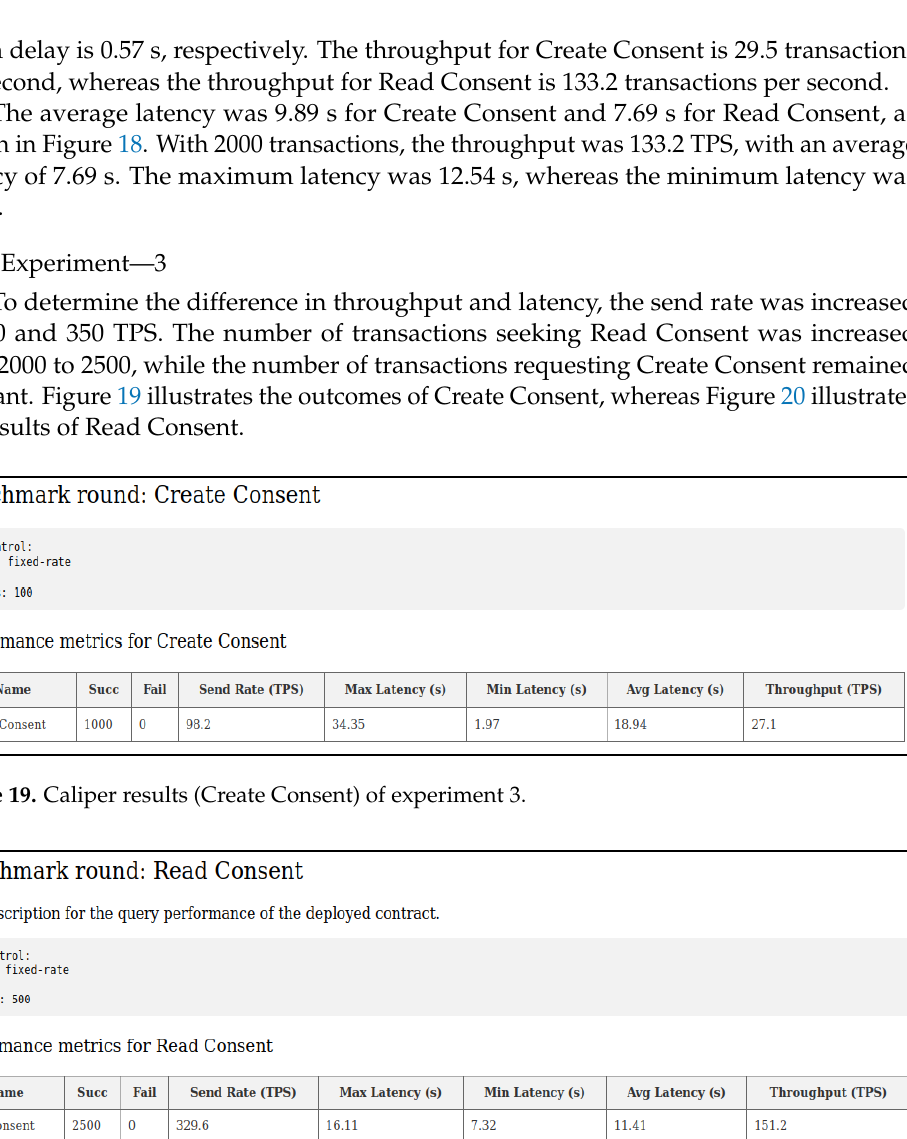
Figure 18. Caliper results for experiment 2.